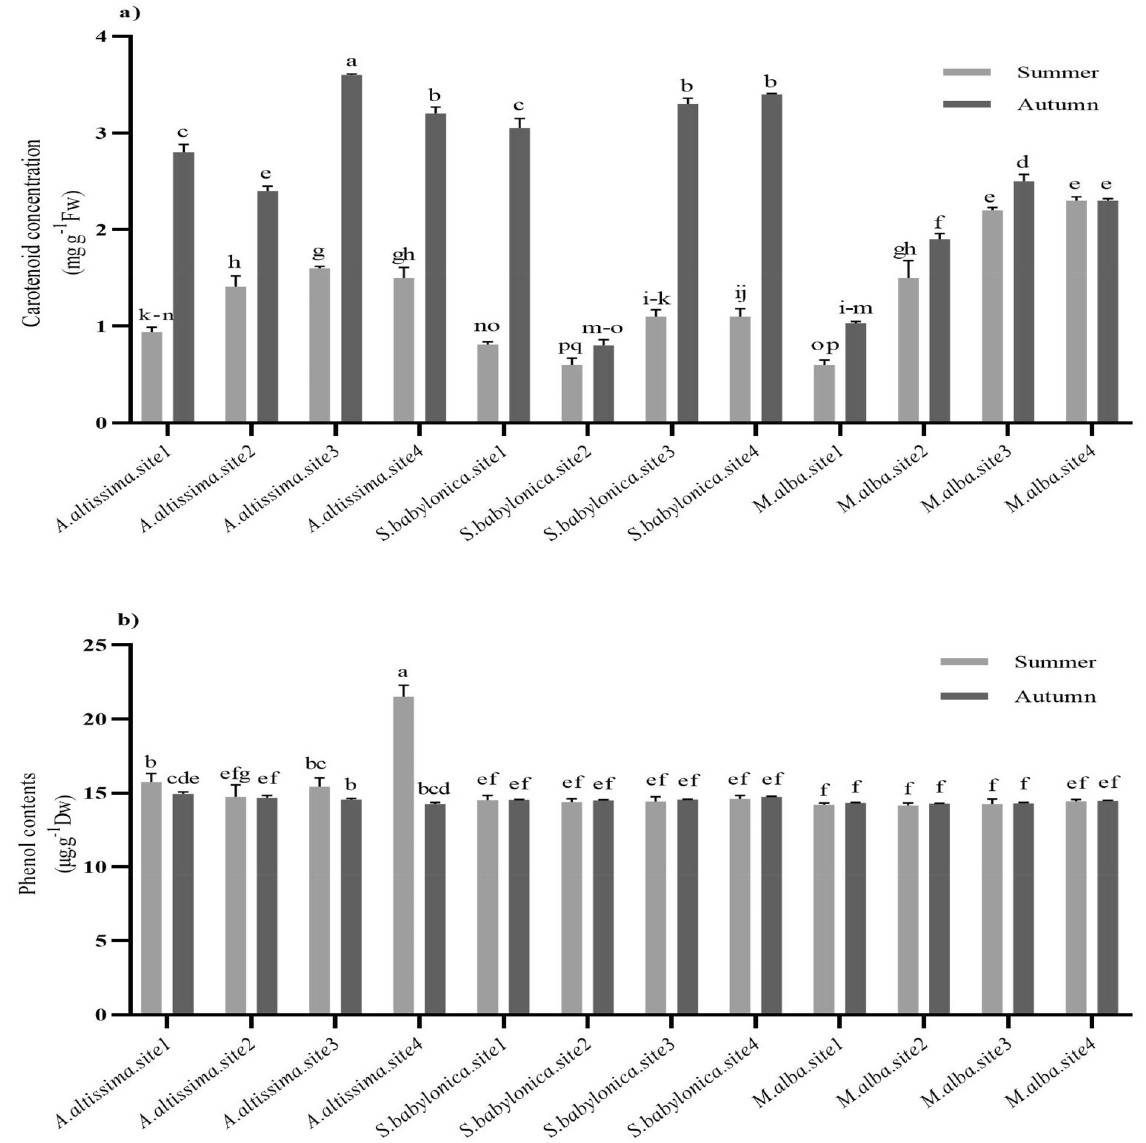
Figure 3. Carotenoid concentrations ( a ) and phenol contents ( b ) of A. altissima, S. babylonica , and M. alba trees in spring, summer, and autumn at sites 1 (Mirdamad Street), 2 (Mirza Babaei Street), 3 (Kargar Shomali Street), and 4 (Azadi Bus Station Street) of Tehran. The means that have at least one common letter did not show a statistically significant difference ( P < 0.05). Data are presented as mean ±